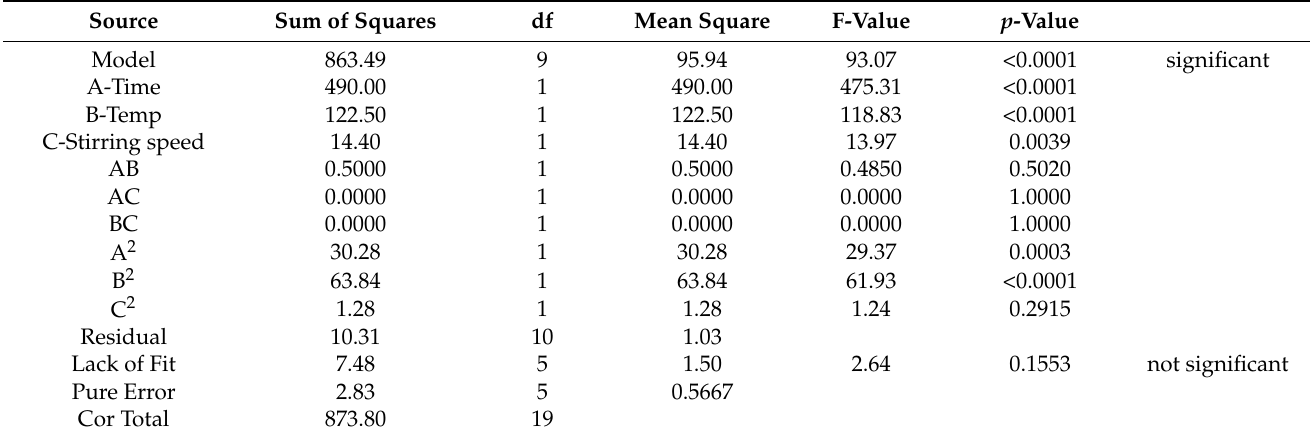
Table 4. ANOVA quadratic model for gold leaching.